Question: What visual encoding does this figure use to show its data?
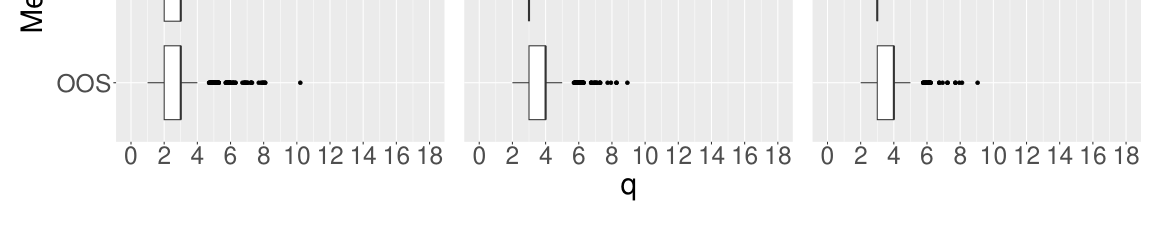
Answer: box